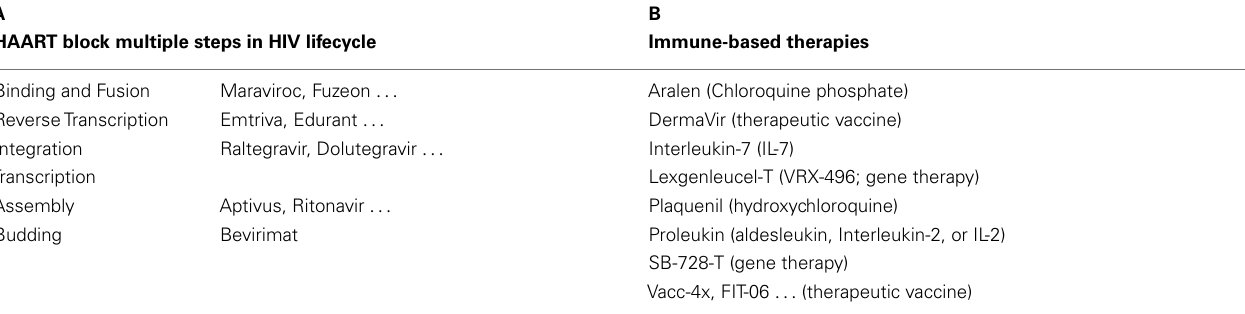
Table 1 |Anti-retroviral and immunotherapeutic drugs used in HIV eradication andAIDS cure. (A) More than 28 approved drugs target five different viral proteins in the HIV lifecycle, plus one targeting the cellular protein CCR5 but none targeting at provirus transcription. (B) Immunotherapies are developed in addition to HAART to reconstitute anti-HIV immunity, in which eight drugs are being used in clinical trials, including the bio-molecules for gene and vaccine therapies. Although a decreased viral load and an increased CD4T-cell number are reported specifically after vaccine treatment in patients with or without cART, the results of immunotherapy approaches remain in phase I or II, and to be confirmed by phase III trials for their efficacy, side effects and